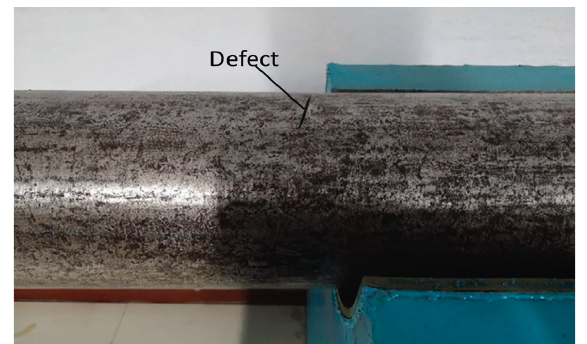
Figure 31: Pipeline defects.